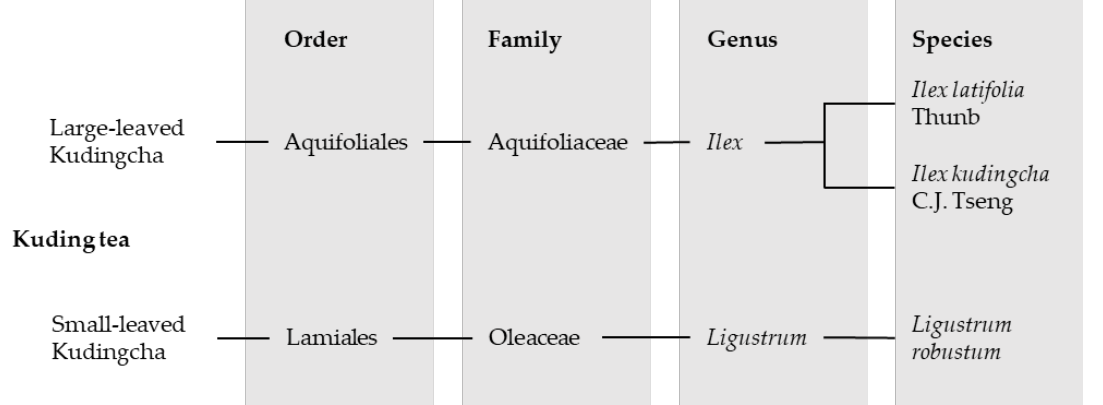
Figure 2. Classification of the most common Kudingcha species consumed in China.